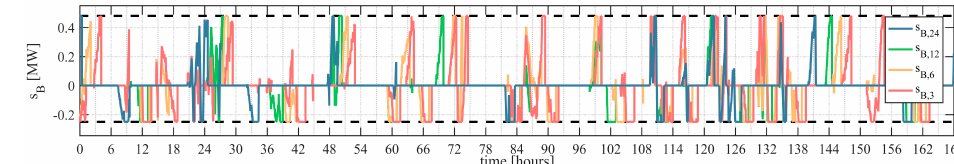
Figure 19. The B power profiles achieved by FBM over a generic week by employing different time horizons.